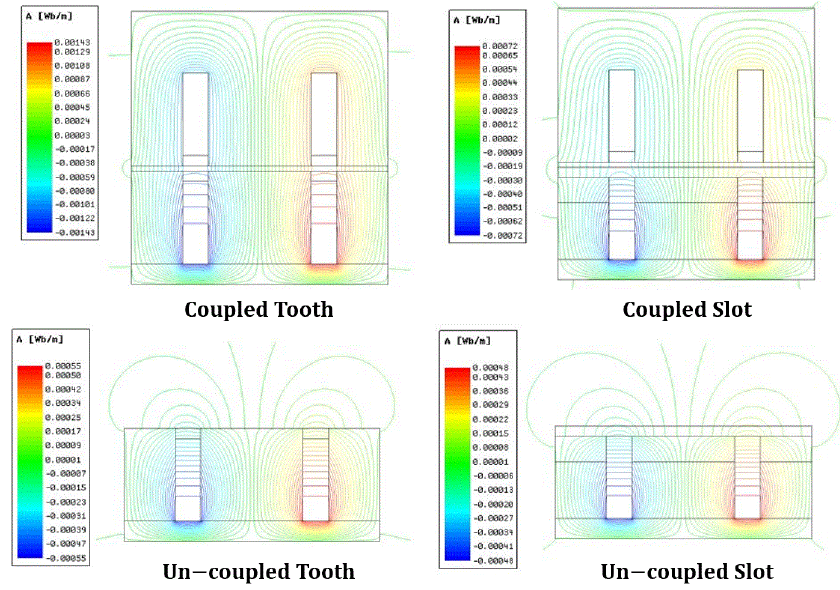
Figure 9. Magnetic flux distribution by primary current